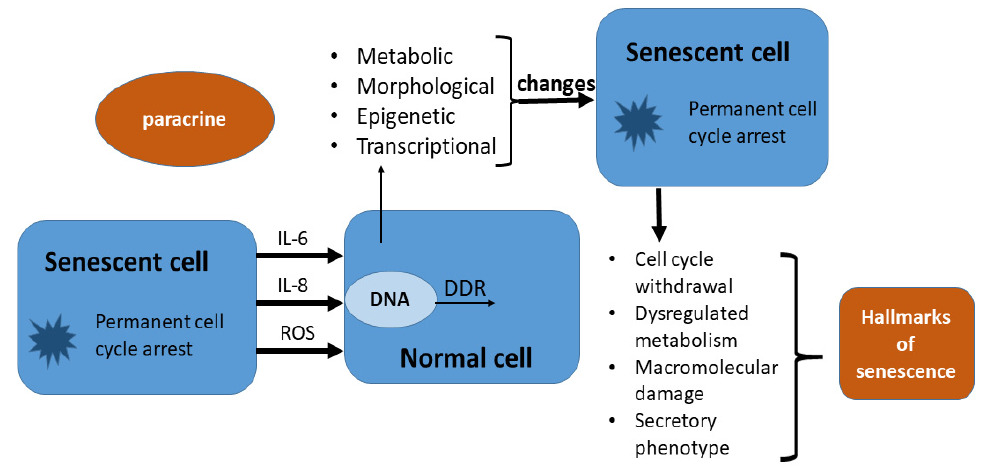
Figure 3. The bystander effect: senescent cells are more secretory active than non-senescent cells and paracrine can affect young cells and induce the start of the senescence process in them. This is accomplished through proinflammatory cytokines and reactive oxygen species (ROS) which cause deoxyribonucleic acid (DNA) damage and initiate DNA damage response (DDR). In this way, the normal cell enters in permanent cycle arrest or senescence. Hallmark of senescence is defined by Gorgoulis et al. [26].